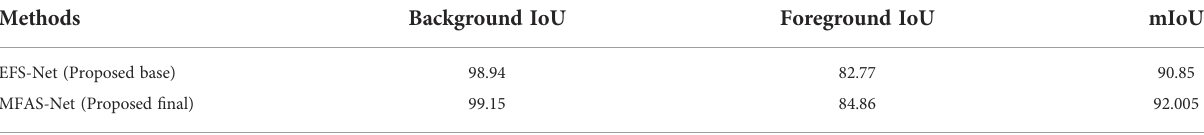
TABLE 2 Comparison between EFS-Net and MFAS-Net ’ s numerical results on the DeepFish dataset.